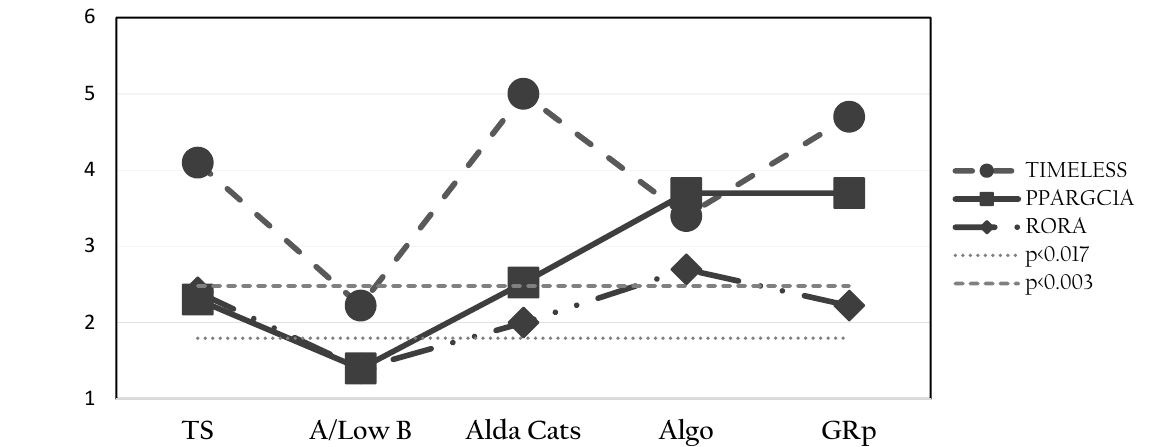
Figure 1. Examination of Li response phenotypes and SNPs within TIMELESS , PPARGC1A and RORA . (An A-dominant model was used for TIMELESS and PPARGC1A ).